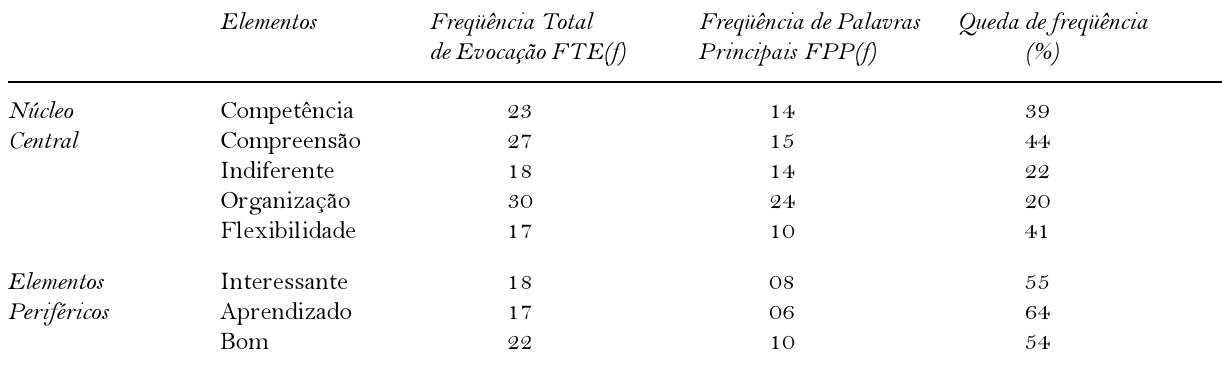
Figura 2 . Elementos principais evocados pelas equipes. Para compor a tabela foram selecionadas as palavras com Freqüência = ou > a 10 e examinamos a queda da freqüência ( N =146).